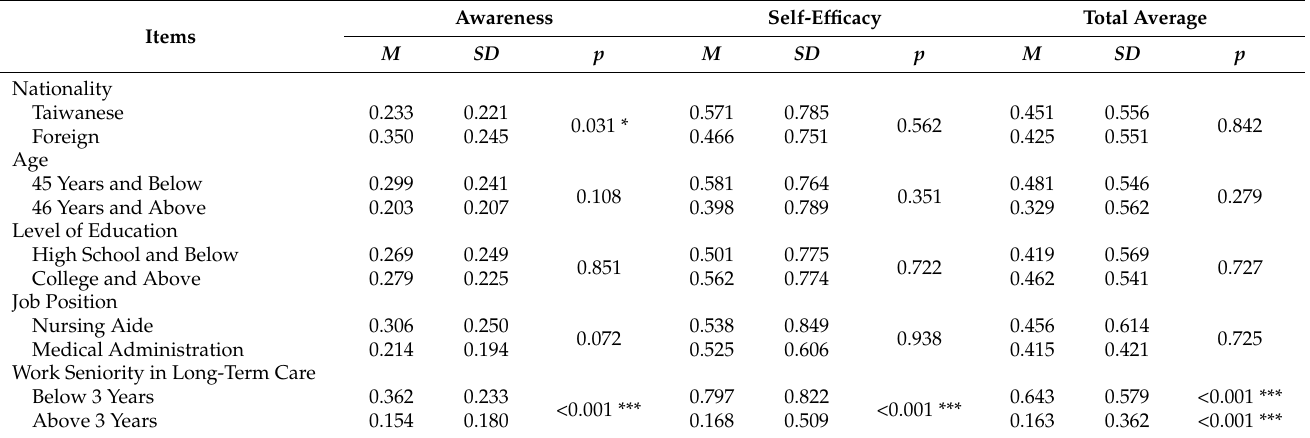
Table 6. Analysis of staff members with different basic profiles and their fire safety training effective- ness (N = 81).